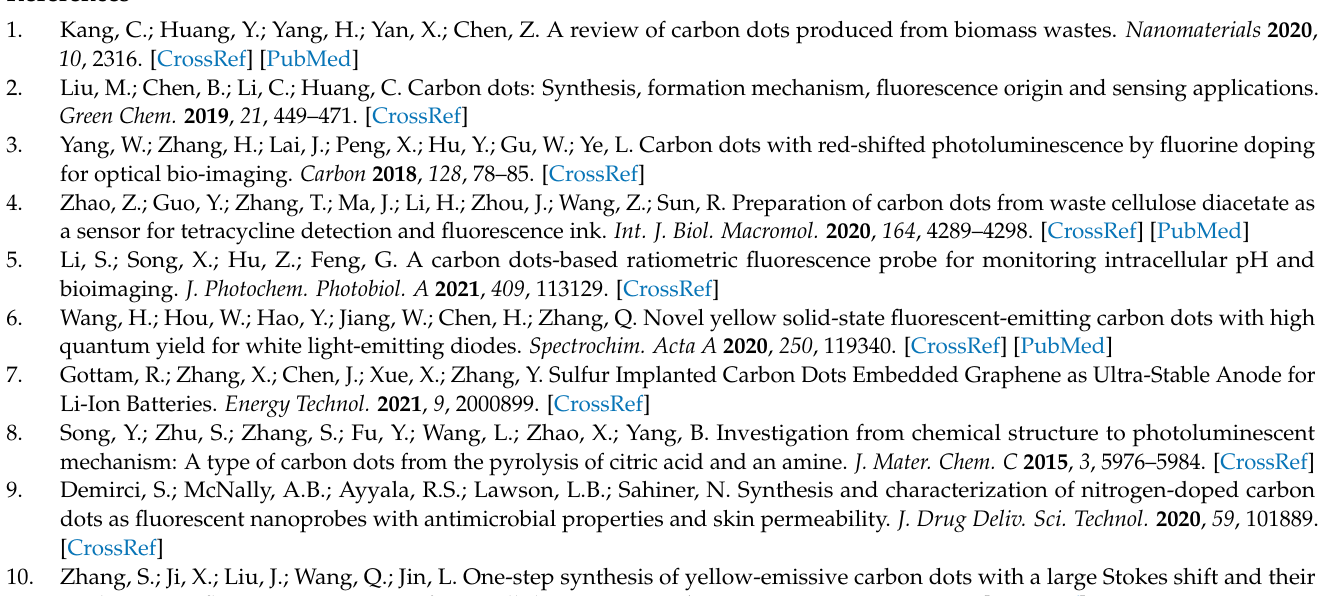
Figure S2: The effect of UV irradiation time on the fluorescence intensity of N, S-CDs; Figure S3: Time-dependent fluorescence changes of N, S-CDs in the presence of rutin; Figure S4: UV-Vis spectra of rutin in the presence and absence of the N, S-CDs; Figure S5: Stern-Volmer plots at different